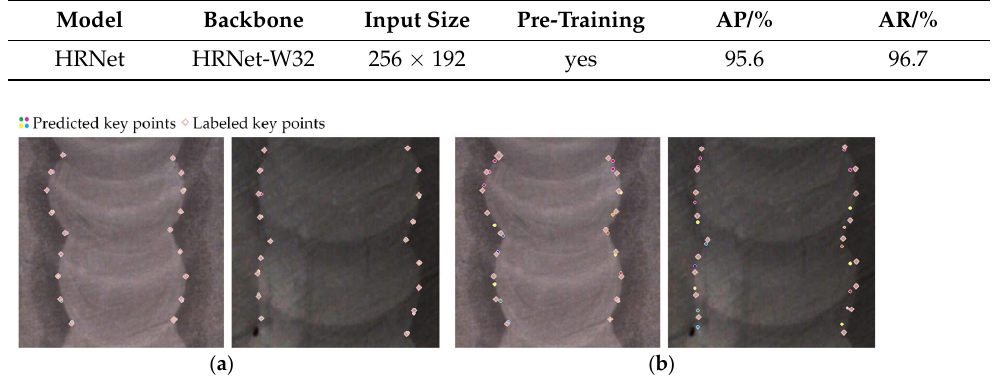
Figure 11. Key point detection visualization results: ( a ) the detection results of the model trained for 150 epochs; ( b ) the detection results of the model trained for 50 epochs.